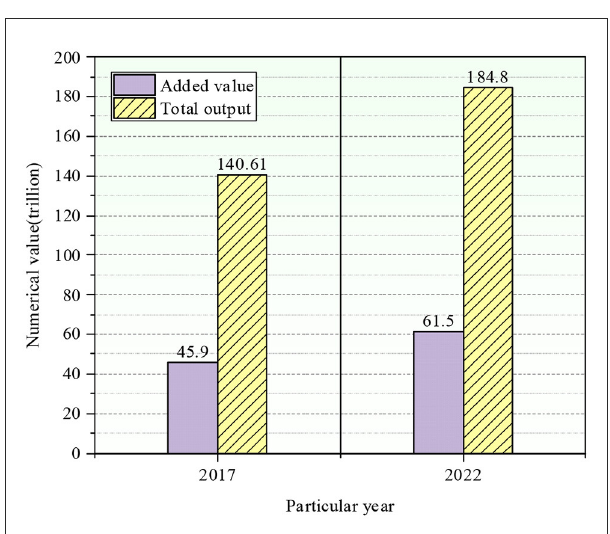
FIGURE8 The added value and a total output of the three industries.